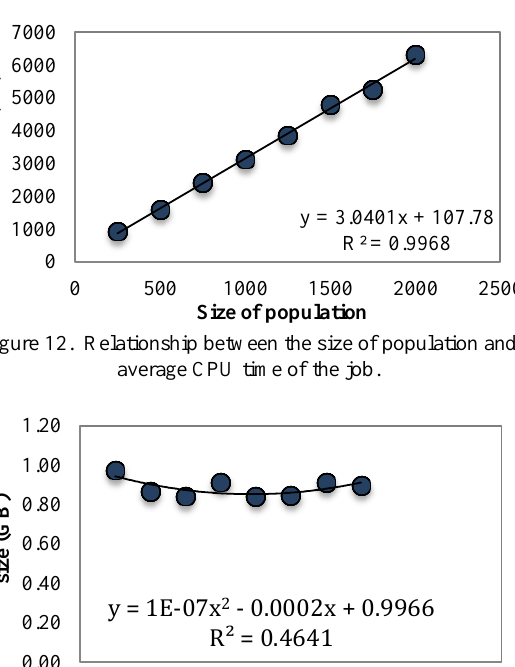
Figure 11. Size of population versus average versus elapsed real time of the job.